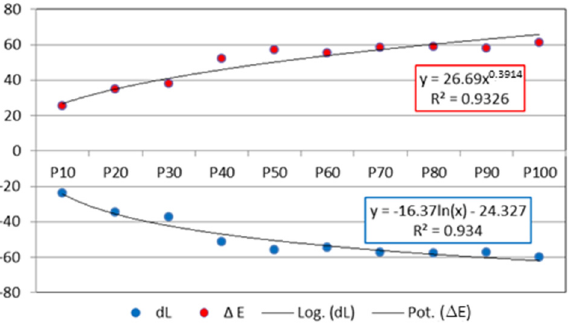
Figure 8. Lightness decrease and total color differences for the laser engraved squares with different powers of the laser beam.